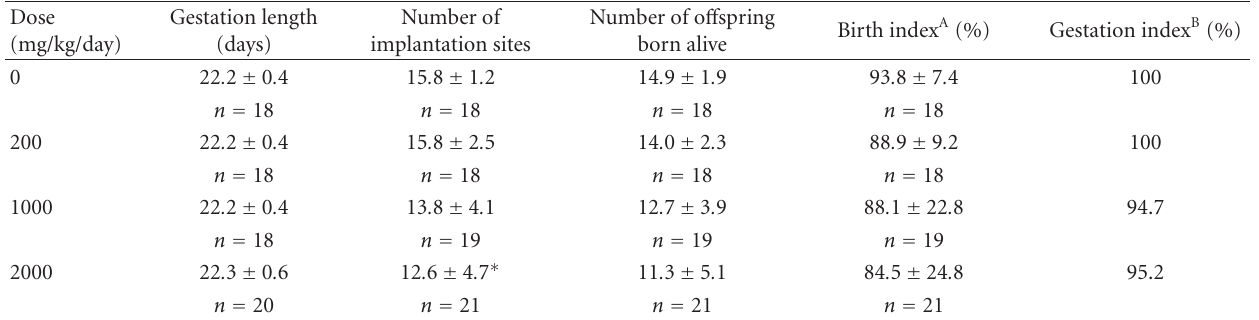
Table 8: E ff ects of SE5-OH administration on F 1 generation rat dam gestation and delivery parameters. Dose